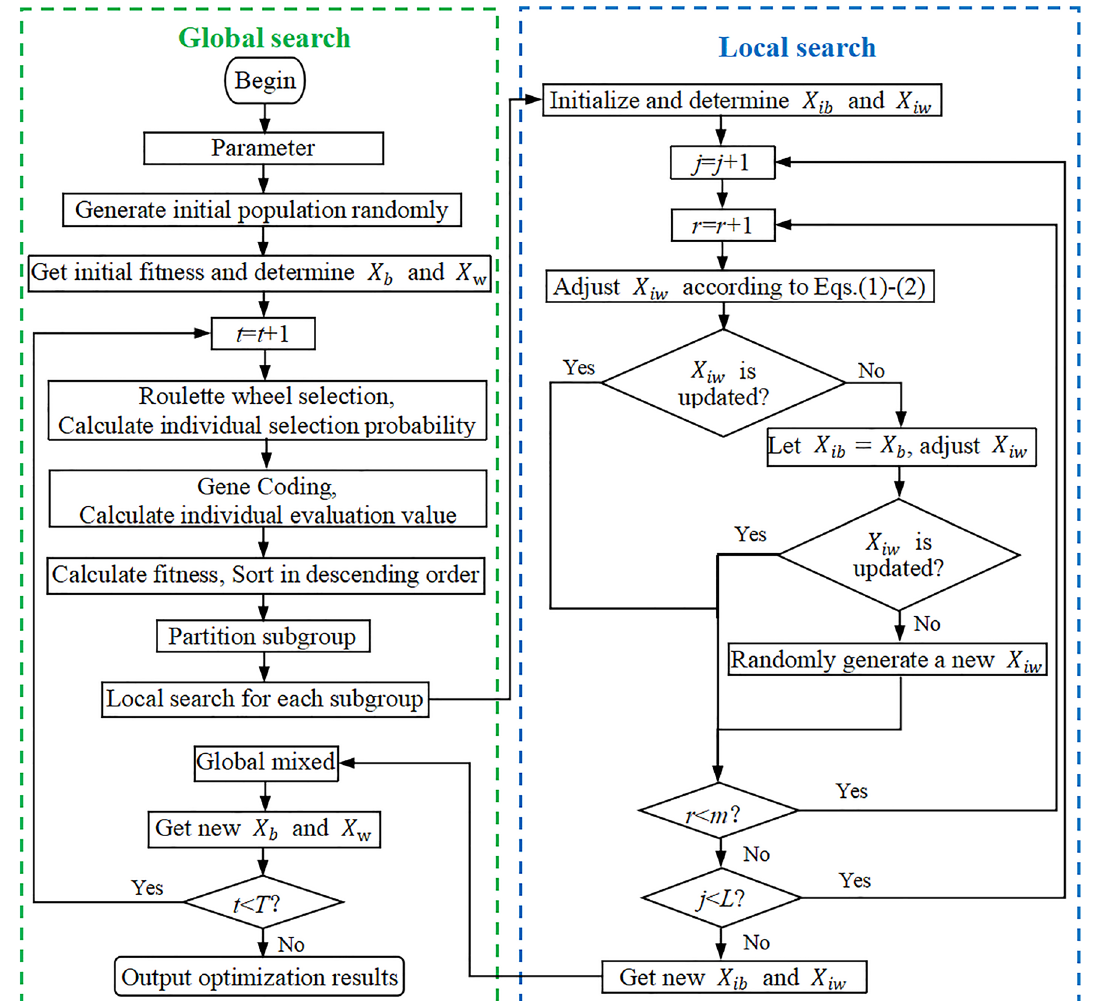
Fig. 3 Flowchart of the ISFLA